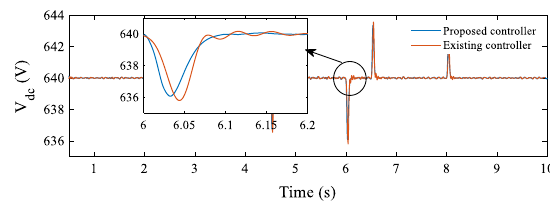
Fig. 8 Under changing operational circumstances, the